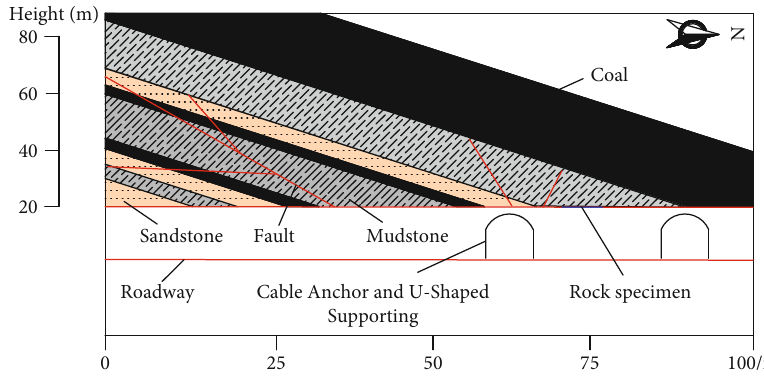
Figure 3: Geological section along 5# coal seam mining area. The obtained rock specimen is located within mudstone that dips approximately 40deg south.